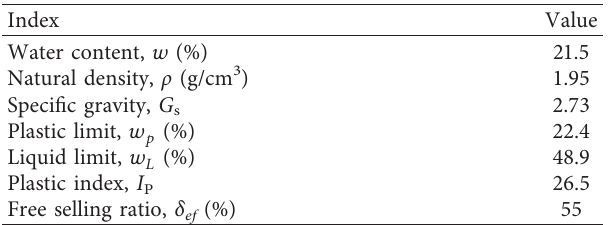
Table 1: Basic physicochemical properties of the tested expansive